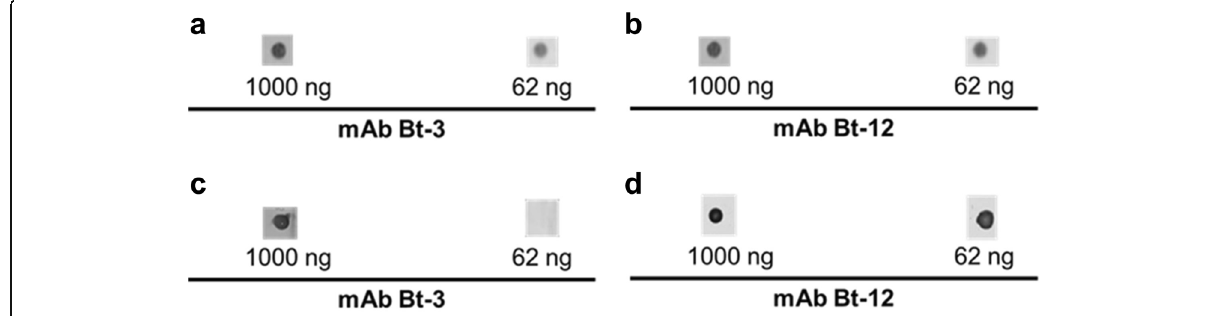
Fig. 5 Analysis of mAbs against B. jararacussu and B. jararaca (south) venoms. One microgram of B. jararacussu or southern B. jararaca venom was applied directly to a nitrocellulose membrane. After blocking, 1000 or 62 nanograms of mAbs was applied. In ( a ) and ( b ) mAbs against B. jararacussu venom and ( c ) and ( d ) mAbs against southern B. jararaca venom. Given the reproducibility of the mAbs against the B. jararacussu and southern B. jararaca venoms, only a representative result for mAb Bt-3 (results from Bt-1, Bt-2, Bt-6 and Bt-10) and another for mAb Bt-12 (results from Bt-11) are